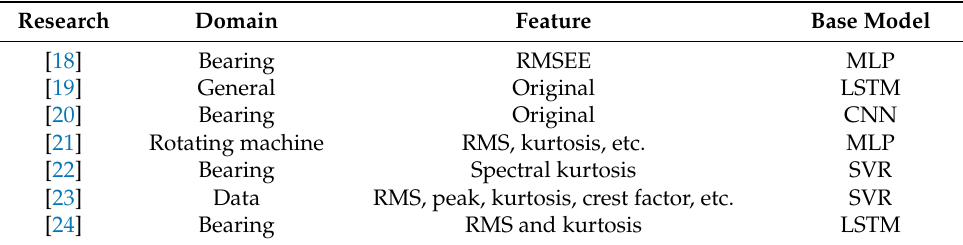
Table 1. Previous studies on RUL